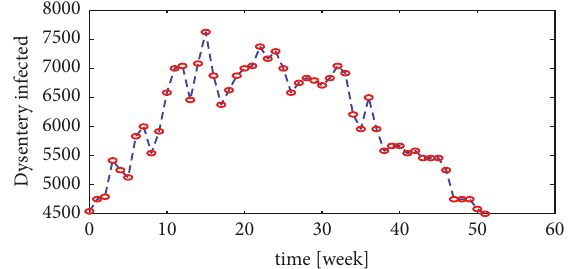
Figure 3: Weekly time series of dysentery diarrhea data in Ethiopia